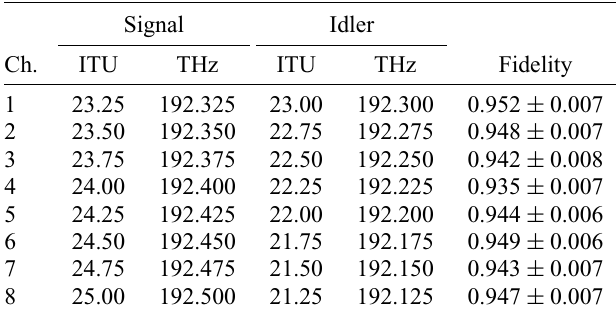
TABLE I. DWDM ITU 25-GHz grid C-band channel num- bers of the signal and the idler photons. The pair of channels in the same row are entangled. Fidelities are with respect to the ideal polarization Bell state | (cid:8) + (cid:2) , and both photons are measured locally at the source prior to transmission.